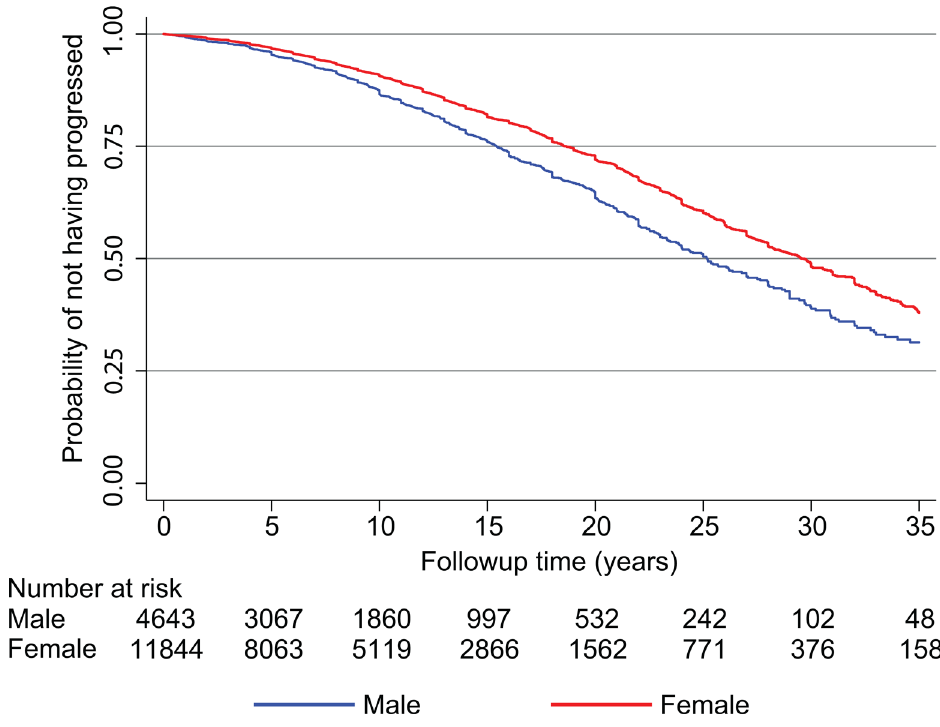
Fig 3. Kaplan-Meier estimates of time to secondary progressive MS by